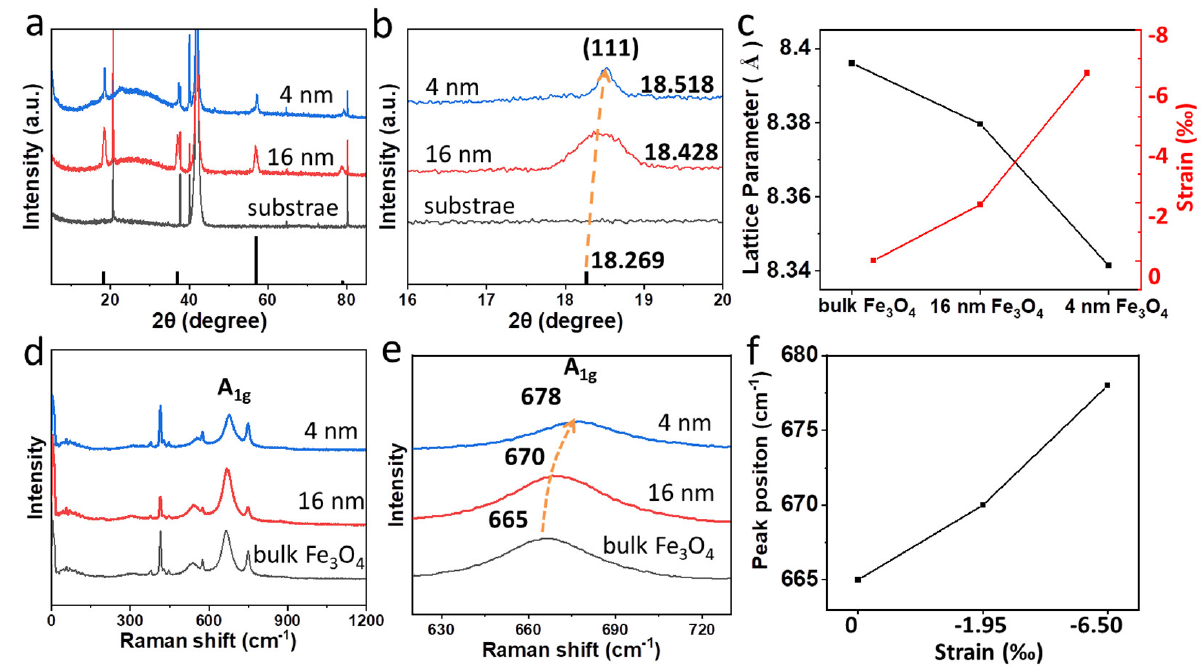
Figure 2. ( a , b ) XRD patterns of Fe 3 O 4 films with different thicknesses; ( c ) the lattice parameter and strain of 4 nm film, 16 nm film and bulk Fe 3 O 4 . ( d , e ) Raman spectra of the 4 nm film, 16 nm film and bulk Fe 3 O 4 ; ( f ) Strain − dependence of Raman peak position.